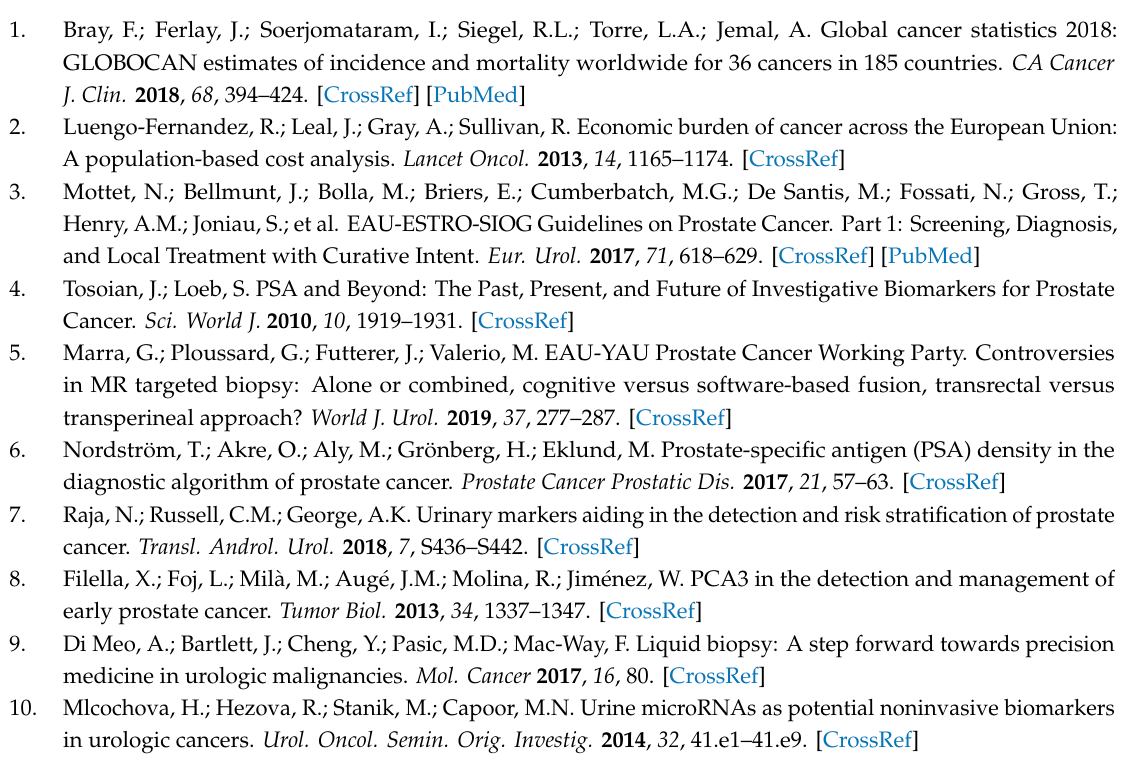
Table S1. Relative expression levels of miRNAs and respective fold changes in urinary sediments from Tf and PCa groups using the sub-cohort of patients with PSA levels ≤ 10 ng / mL ( n = 34). Table S2. Assessment of the diagnostic power of PSA, PSAD and miRNA expression levels in urinary sediments by ROC curve analyses using the whole patient cohort ( n = 50). Figure S1. ROC curve analysis of (A) miR-145 and (B) miR-26a expression levels in urinary sediments using the whole study cohort ( n = 50). Table S3. Assessment of the diagnostic power of PSA, PSAD and miRNA expression levels in urinary sediments by ROC curve analyses using the sub-cohort of patients with PSA levels ≤ 10 ng / mL ( n = 34). Figure S2. ROC curve analysis of (A) miR-145 and (B) miR-21 expression levels in urinary sediments using the sub-cohort of patients with PSA levels ≤ 10 ng / mL ( n =